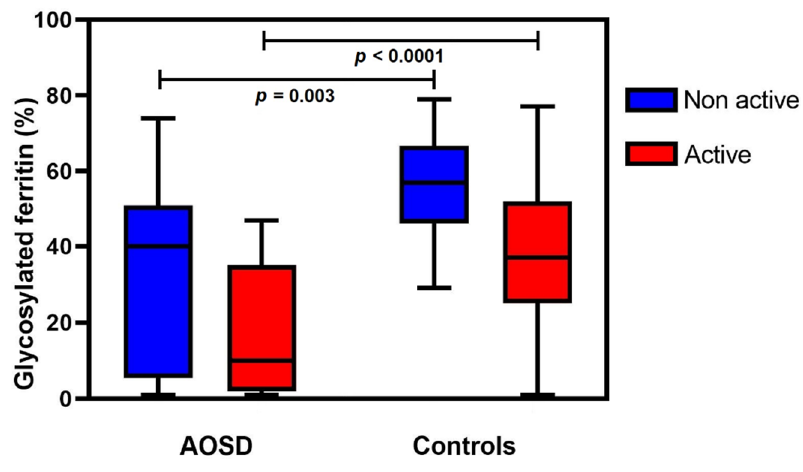
Figure 3. Glycosylated ferritin level according to disease activity in adult-onset Still’s disease (AOSD) and controls.